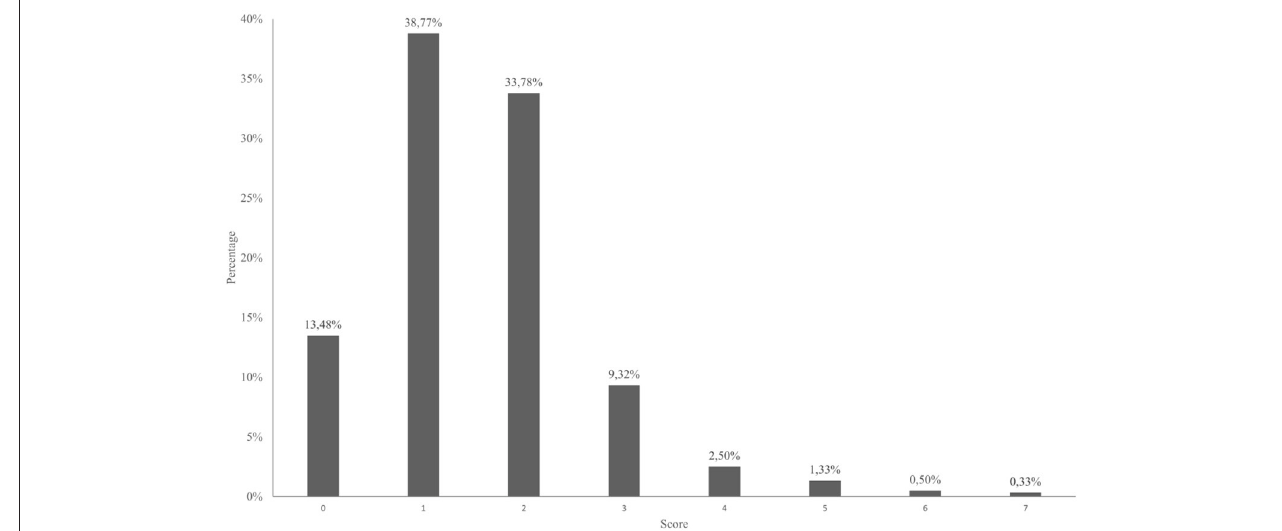
FIGURE 1 | Distribution of sum scores in screening tool for new arrivals during study period.